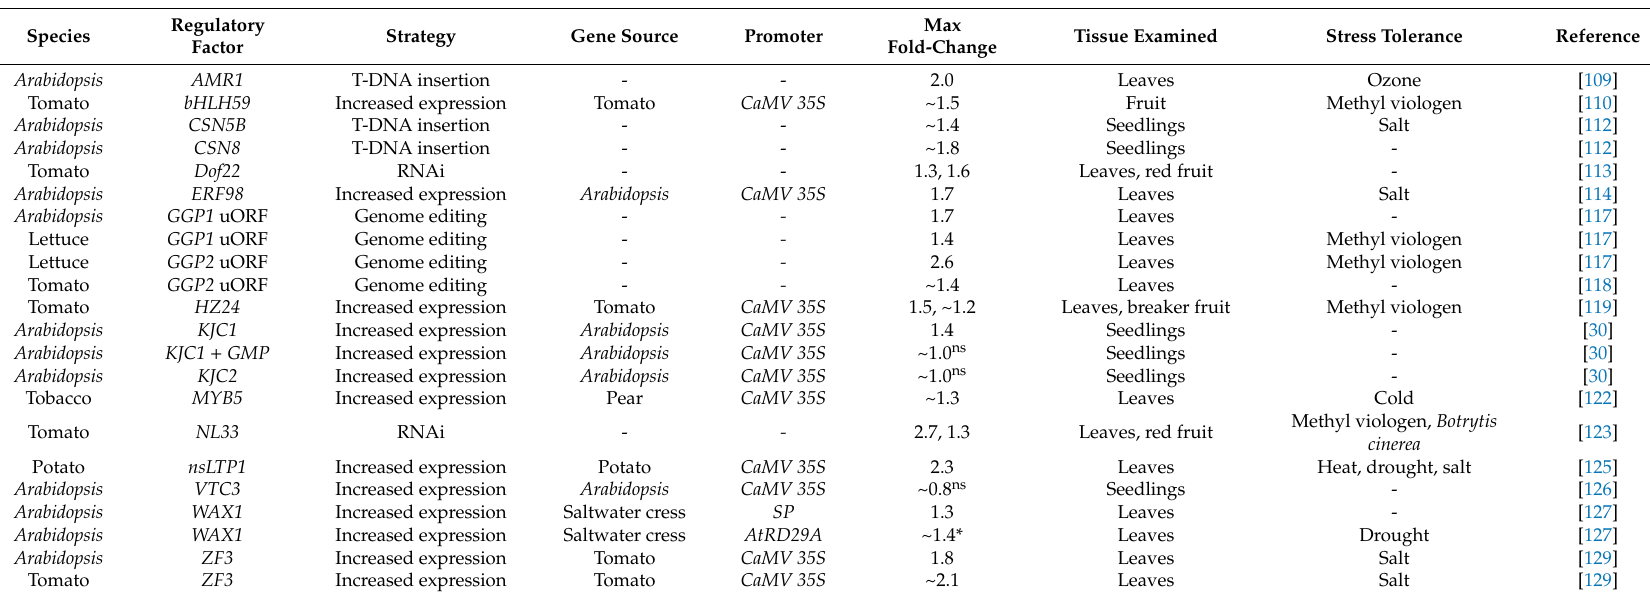
Max Tissue Examined Stress Tolerance Reference Fold-Change